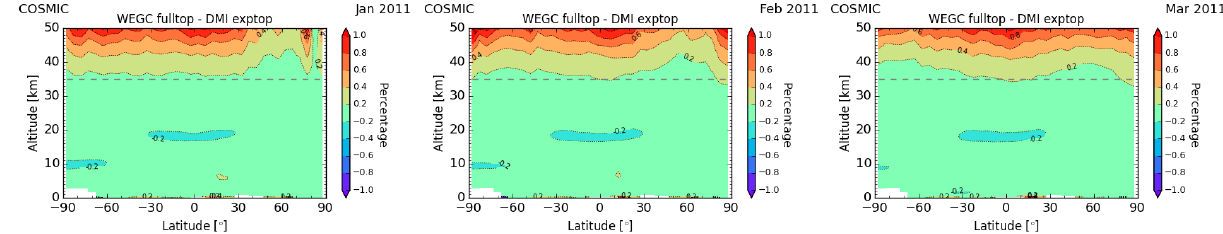
Figure 6. Difference in API refractivity climatologies between WEGC and DMI processing from January to March 2011, using the same bending angle profiles as input (DMI L1b).